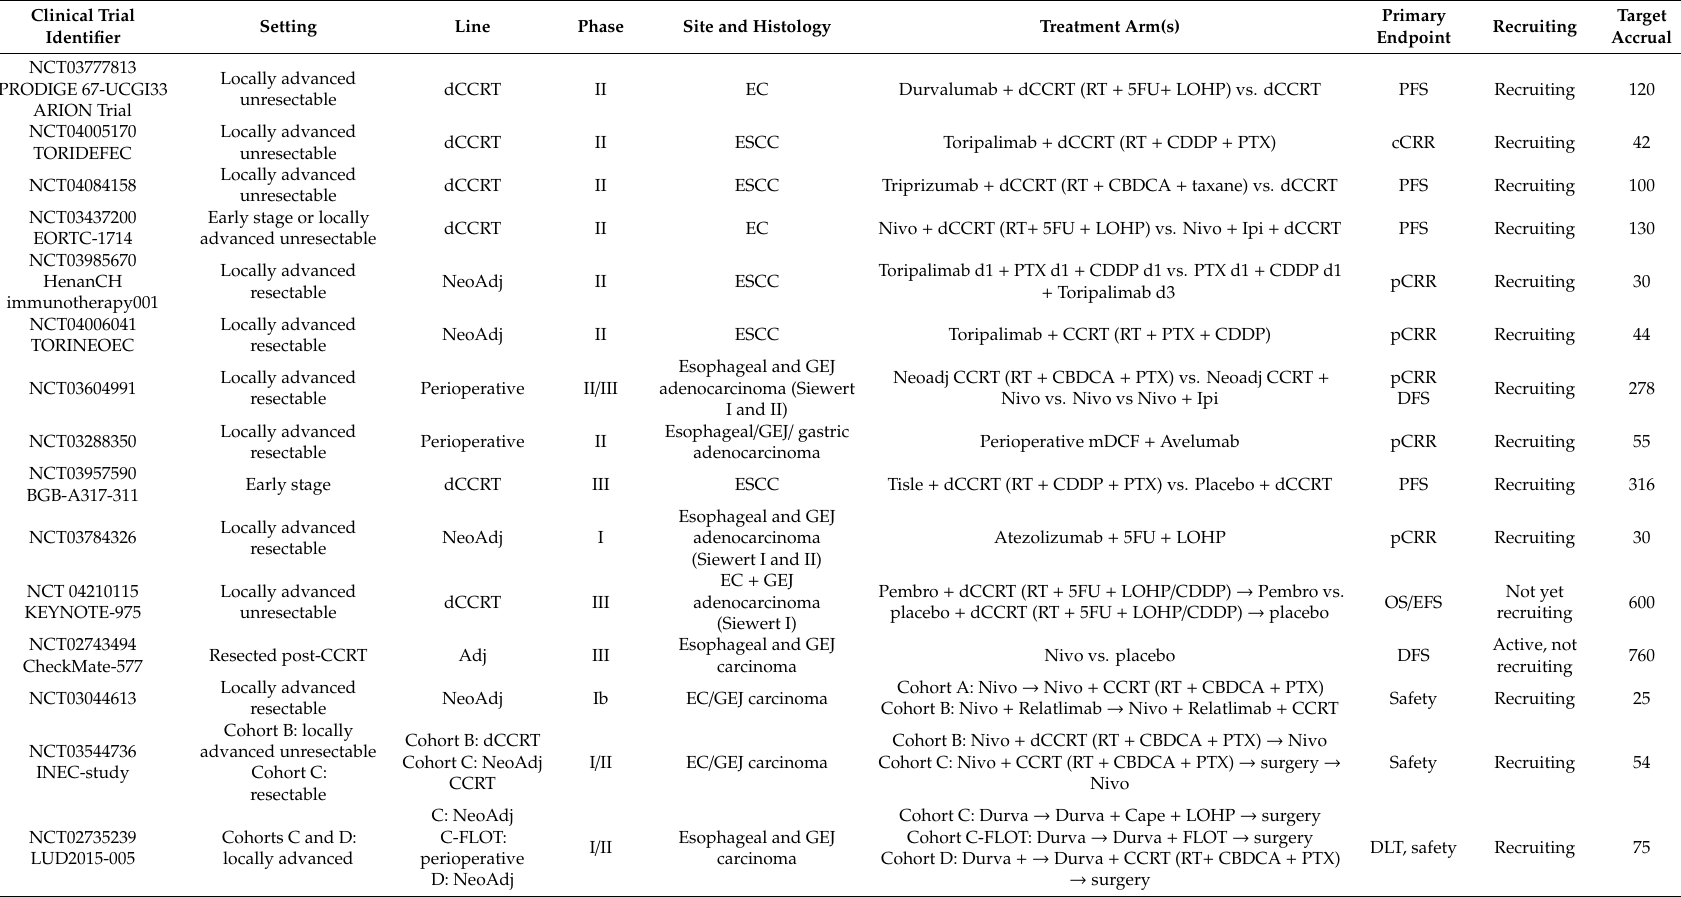
Table 3. Selected ongoing trials in non-metastatic esophageal